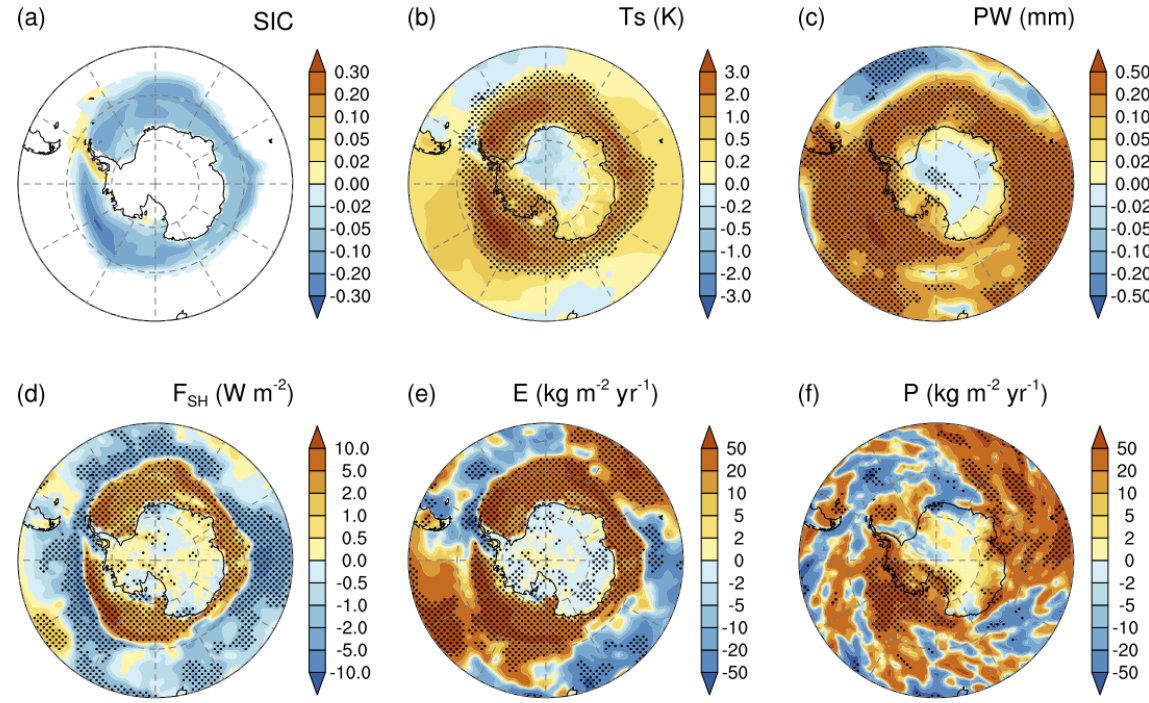
Figure 3. Annual mean differences in (a) sea-ice concentrations (SICs), (b) surface temperature ( T s ), (c) total precipitable water (PW), (d) surface sensible heat flux ( F sh ), (e) surface evaporation and sublimation ( E ), and (f) surface precipitation ( P ) between the low- and high- SIC cases. Stippling on the maps indicates that the differences are statistically significant at the 90% confidence level based on Student’s t